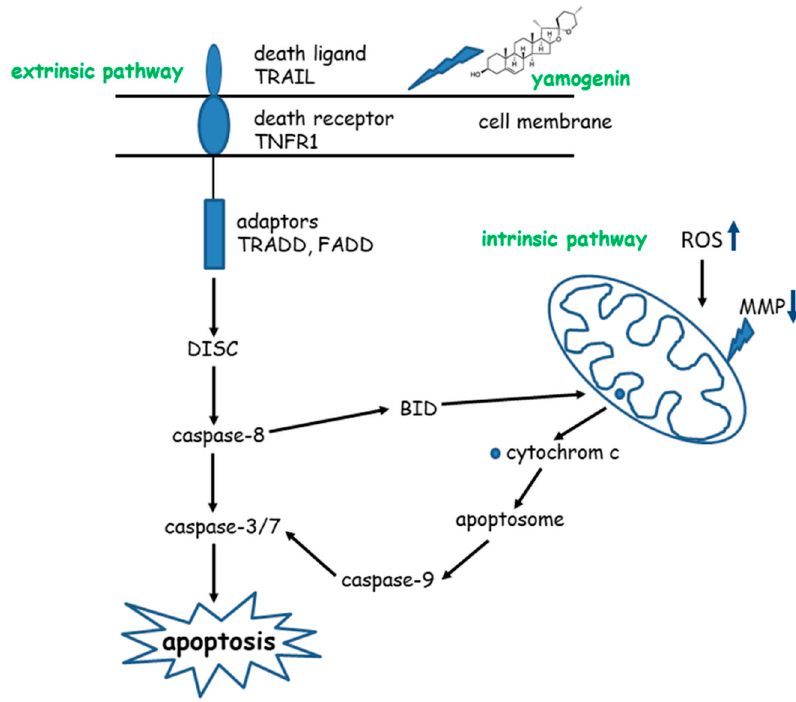
Figure 13. Pathways of apoptosis induced by yamogenin in SKOV-3 cells. Saponins are potential anticancer compounds with different mechanisms of action.